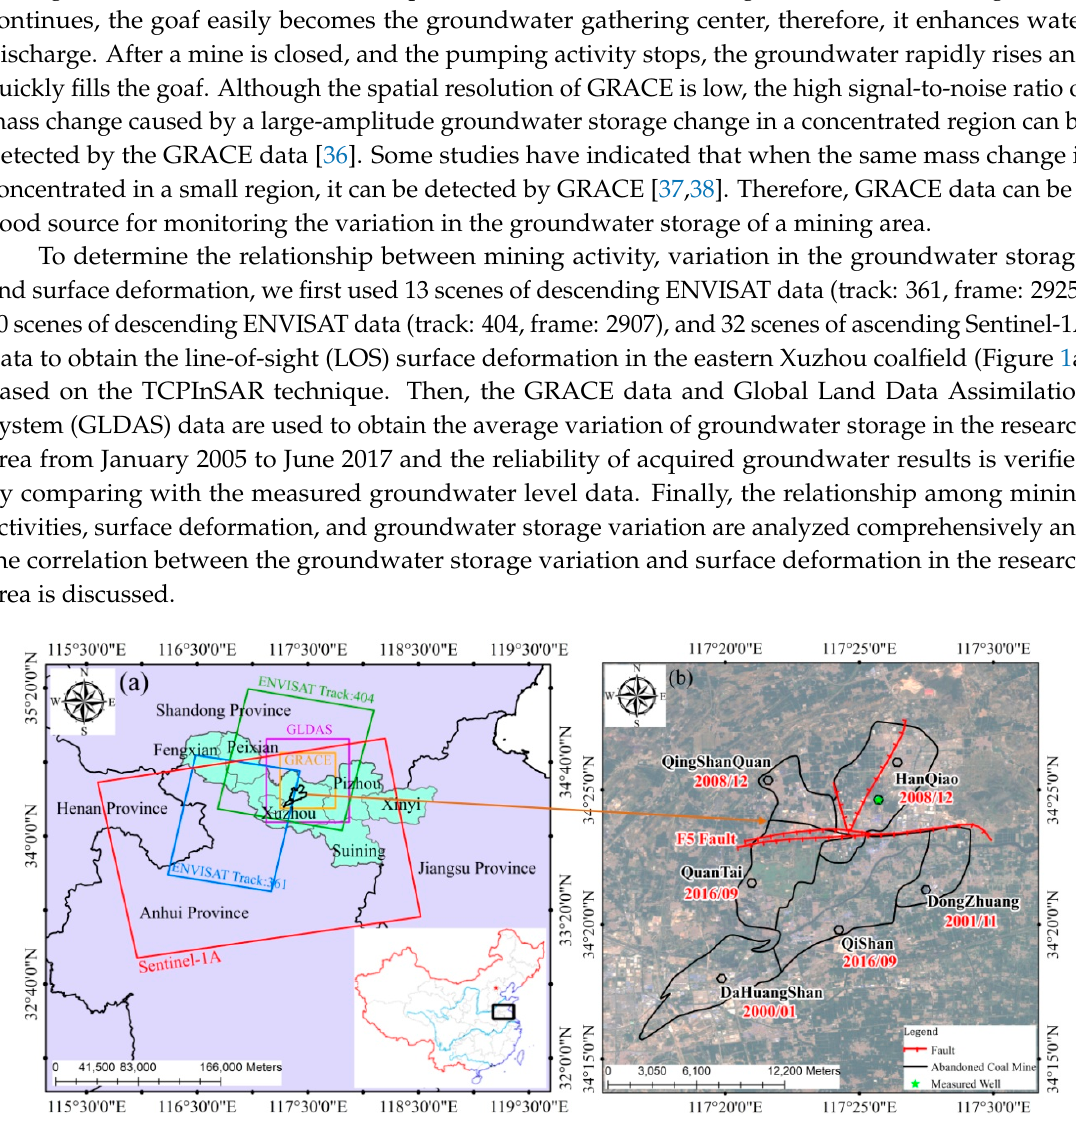
Figure 1. Overview of the research area. ( a ) Geographical location of the research area. The red, blue, green, purple, and orange rectangular boxes are, respectively, the coverage range of the Sentinel-1A data, the ENVISAT (track: 361, frame: 2925 and track: 404, frame: 2907) data, the GLDAS data and the GRACE data; ( b ) mining area distribution map. The base map in Figure 1b is the Landsat8 optical image.